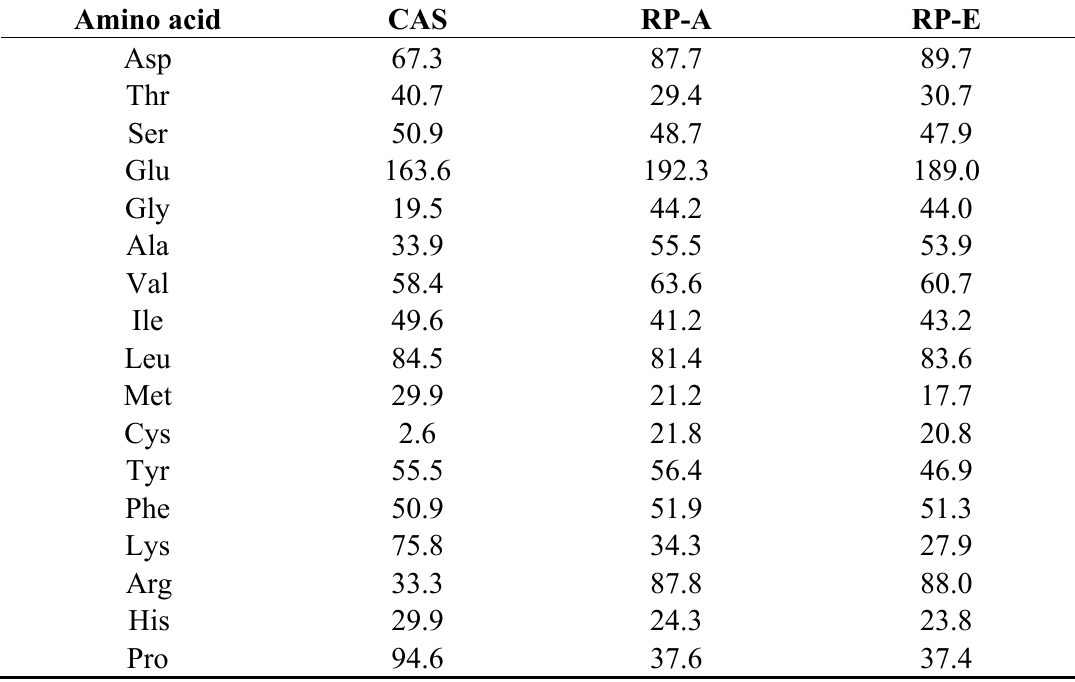
Table 3. Amino acid composition of dietary protein